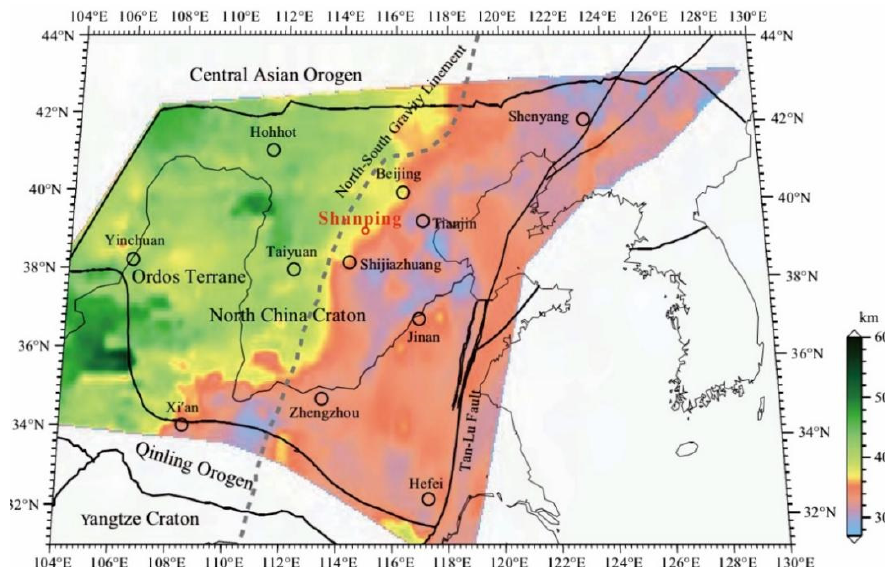
Figure 4. Map of Moho depth distribution of the NCC (modified from [35]).